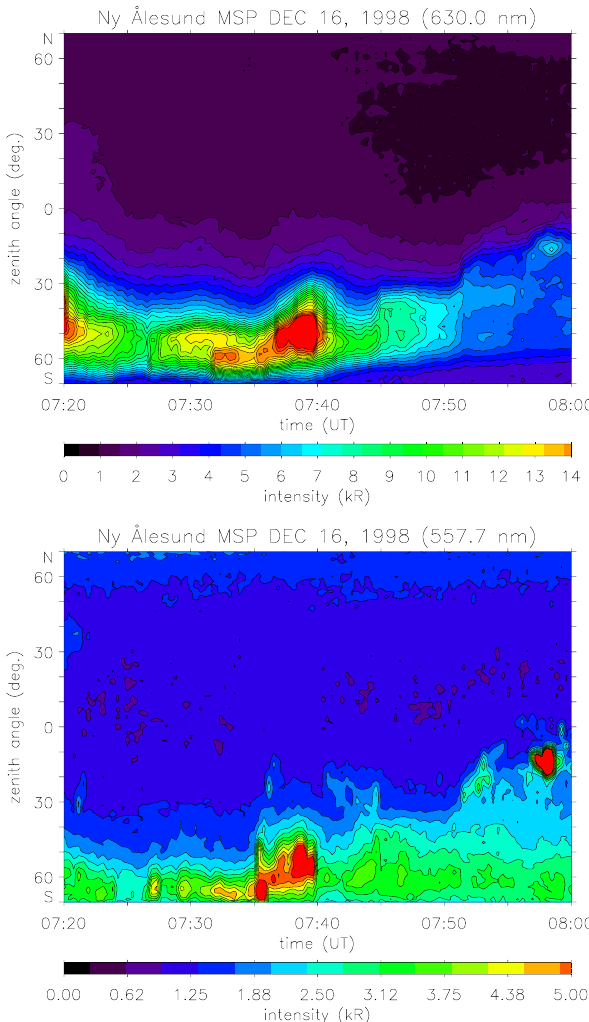
Fig. 2. Color-coded meridian scanning photometer (MSP) obser- vations of line of sight auroral intensities at (a) 630.0 nm and (b) 557.7 nm as a function of zenith angle. North is up. The obser- vations were recorded from Ny Ålesund (76 ◦ MLAT) during the interval 0720–0800 UT on 16 December